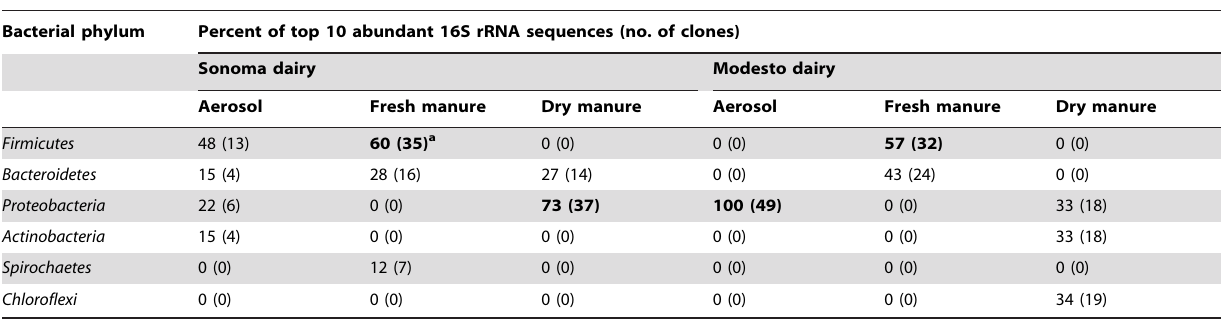
Table 2. Classifier assignment of 10 abundant sequences from aerosol and manure samples from both dairies.